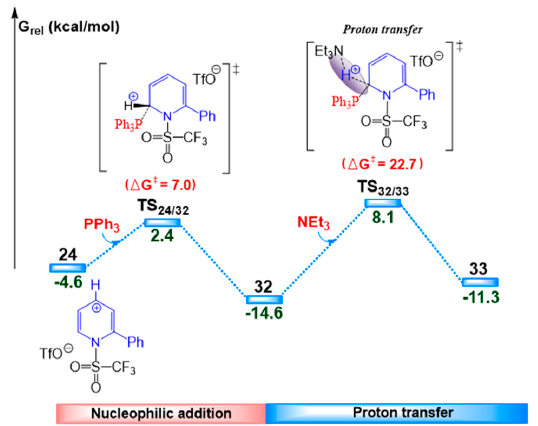
Figure 7. Free energy profile of 2-Ph-pyridine phosphination with PPh 3 to give the ortho-substituted product. Table 3. Strain energies of pyridine, phosphonate and NEt 3 moieties in the TS 27/28 and TS 32/33 transi ‐ tion states.